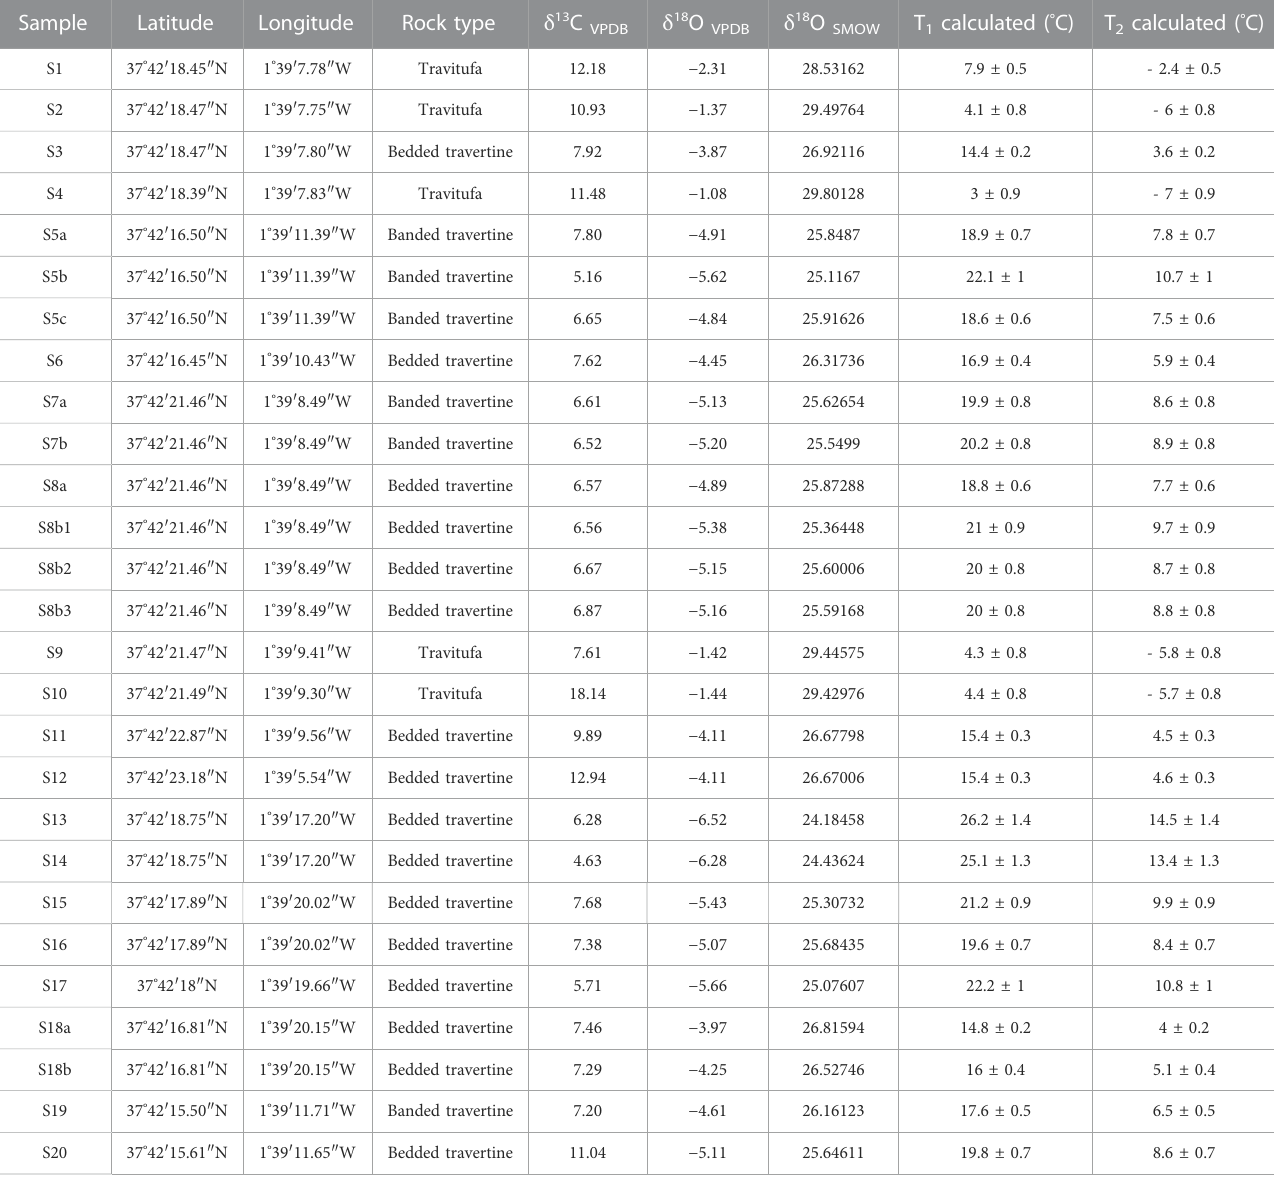
TABLE 2 δ 18 O and δ 13 C isotopic composition and paleotemperatures of Carracalaca site samples. Sample Latitude Longitude Rock type